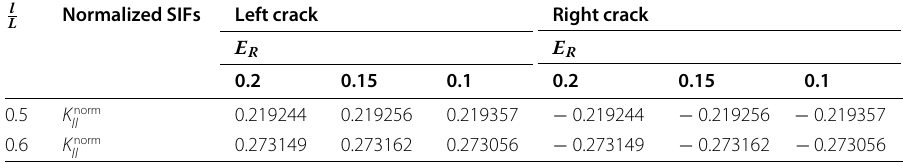
Table 6 Influence of enrichment radii on the computation of SIFs for square plate with round hole and two cracks, R / L = 0 .